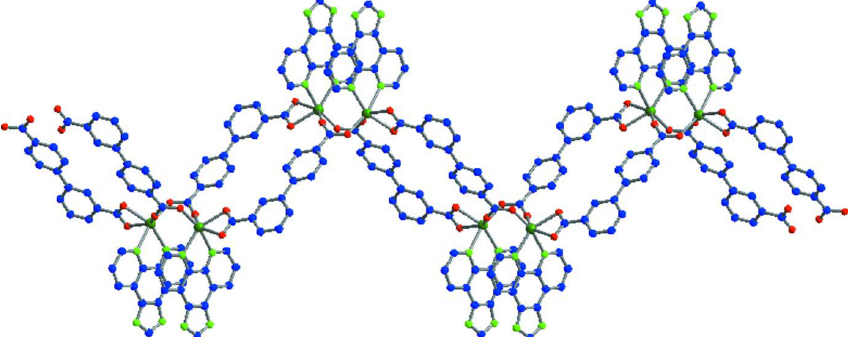
Figure 2 View of the one-dimensional zigzag chain running along c axis in compound Poly[( µ -biphenyl-3,4 ′ -dicarboxylato- κ 4 O 3 : O 3 ′ : O 4 ′ , O 4 ′′ )(1 H - imidazo[4,5- f ][1,10]phenanthroline- 3 κ 2 N 7 , N 8